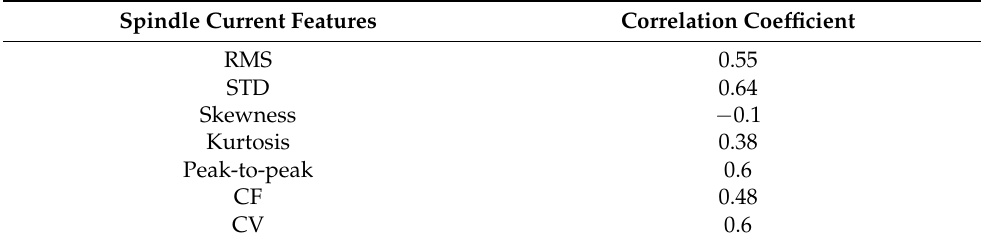
Table 5. Pearson correlation coefficients between the statistical features of spindle current and the Ra